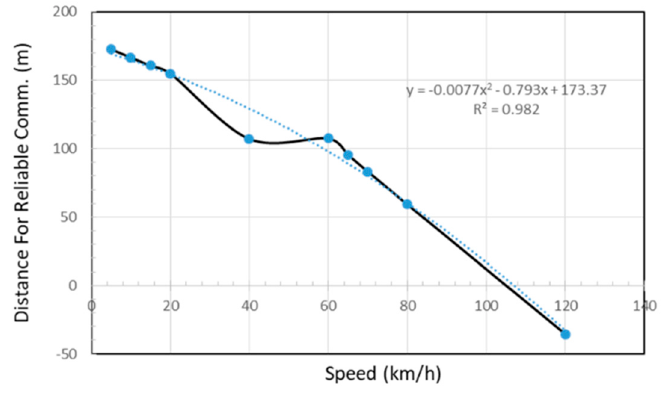
Figure 23. Speed vs. Distance for Reliable Communication (80% PSR).